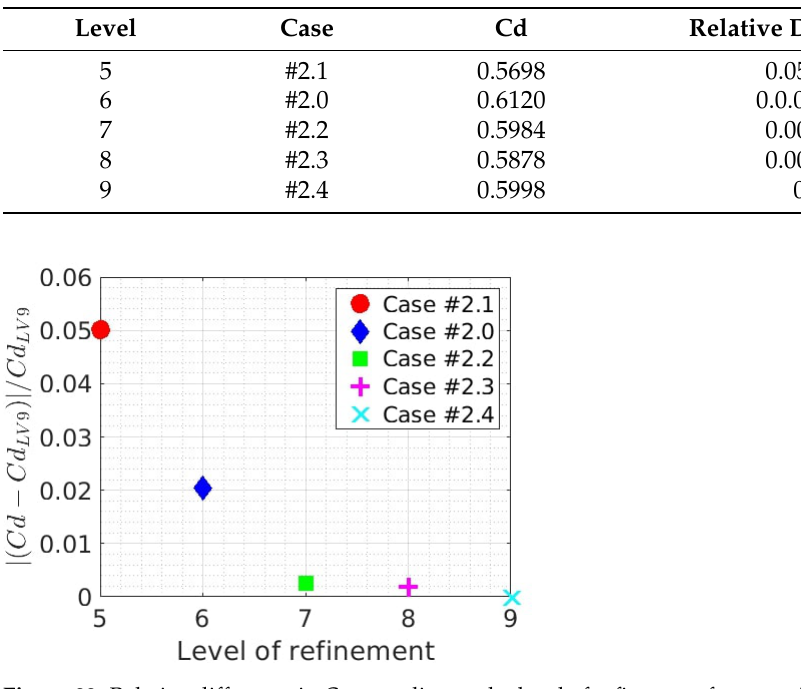
Figure 22. Relative difference in C d according to the level of refinement for cases #2.0 (blue lozenge), #2.1 (red dot), #2.2 (green square), #2.3 (pink plus), #2.4 (cyan cross) and